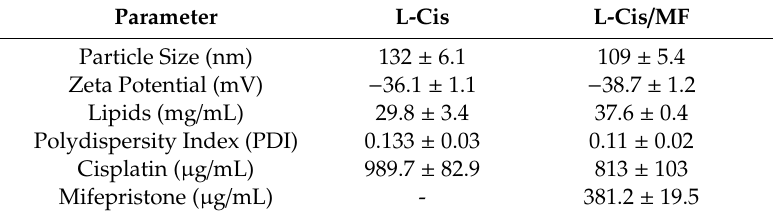
Table 1. The main physicochemical parameters, measured immediately after the preparation of liposomes, loaded with cisplatin /